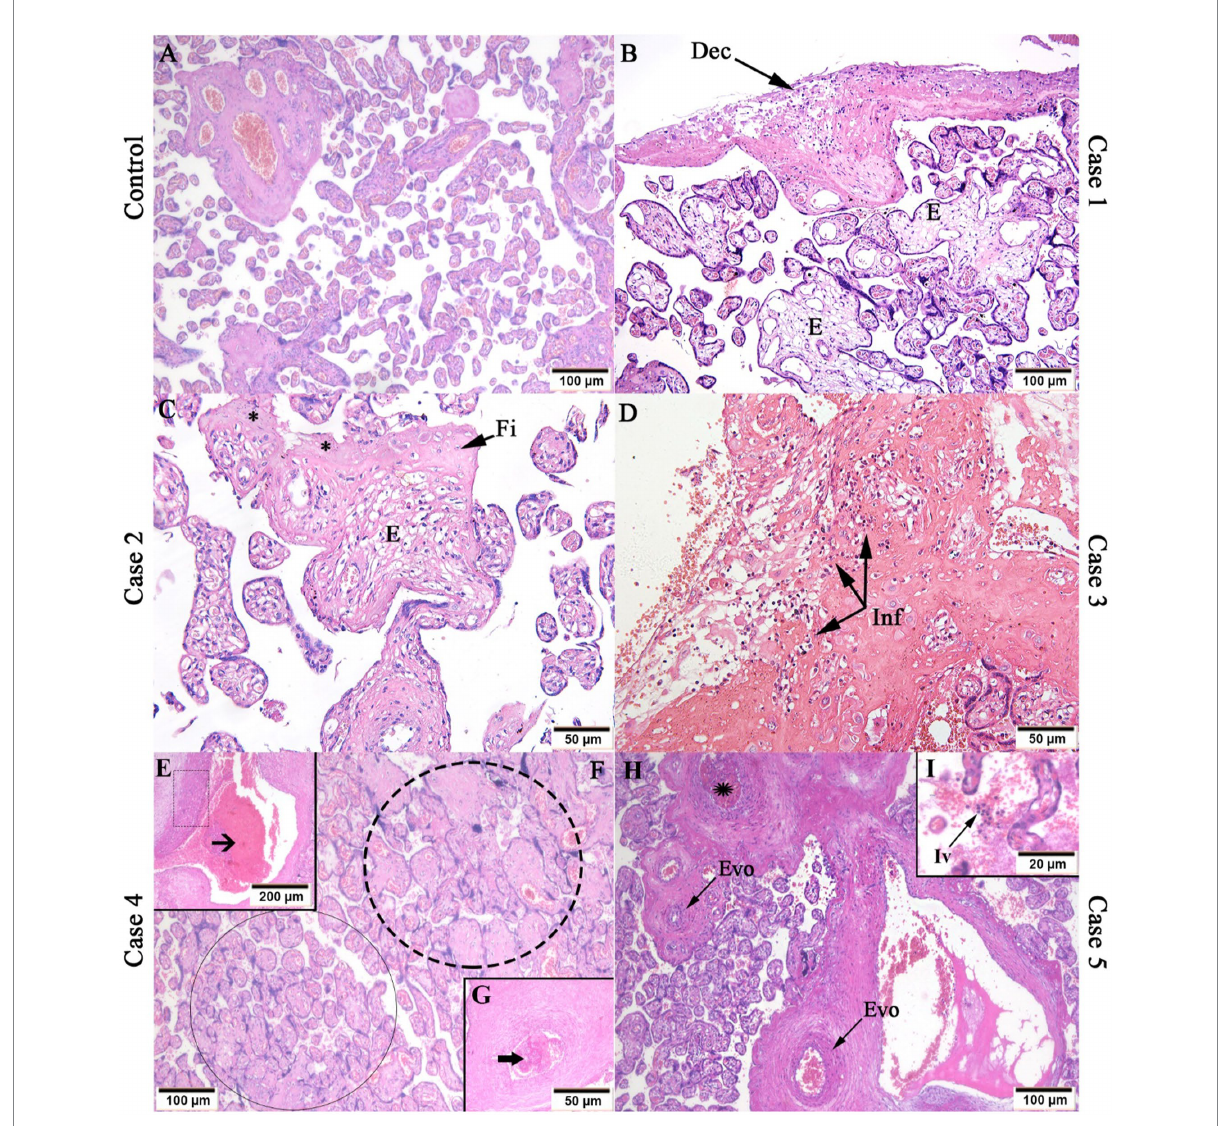
FIGURE 1 Histopathological analysis of CHIKV infected placenta tissues. (A) Control placenta tissue with regular aspects; (B) Deciduitis (Dec) and villous edema (E) in case 1; (C) Fibrin deposits (Fi), edema (E) and necrosis (*) in case 2; (D) Inflammatory infiltrate (Inf) in case 3; (E) Stem vessel vascular intramural fibrinoid deposition (dotted rectangle) and subocclusive thrombosis (black arrow); (F) avascular villi with stromal fibrosis (black circle) and villous stromal-vascular karyorrhexis (dotted circle); (G) Stem vessel with occlusive thrombosis (black thick arrow) in case 4; (F) Stem vessel obliteration/fibromuscular sclerosis (Evo) and thrombosis (black star); intervillositis (Iv) in case 5. Magnification: 5× (E) , 10× (A,B,F,H) , 20× (C,D,G) , 40× (I)